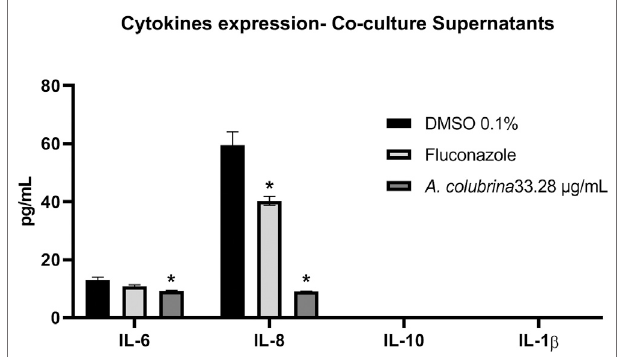
FIGURE8| Proandanti-in fl ammatorycytokinesexpressionofIL-6,IL-8, IL-10 e IL-1 β by human gingival fi broblasts after 8 h of infection with C. albicans and treatment with A. colubrina extract (33.28 μ g/ml). HGF: only cells; DMSO 0.1%: vehicle control; Fluconazole (10 μ g/ml): positive control. Values shown with asterisk (*) are statistically signi fi cant when compared to the vehicle control ( p < 0.05).